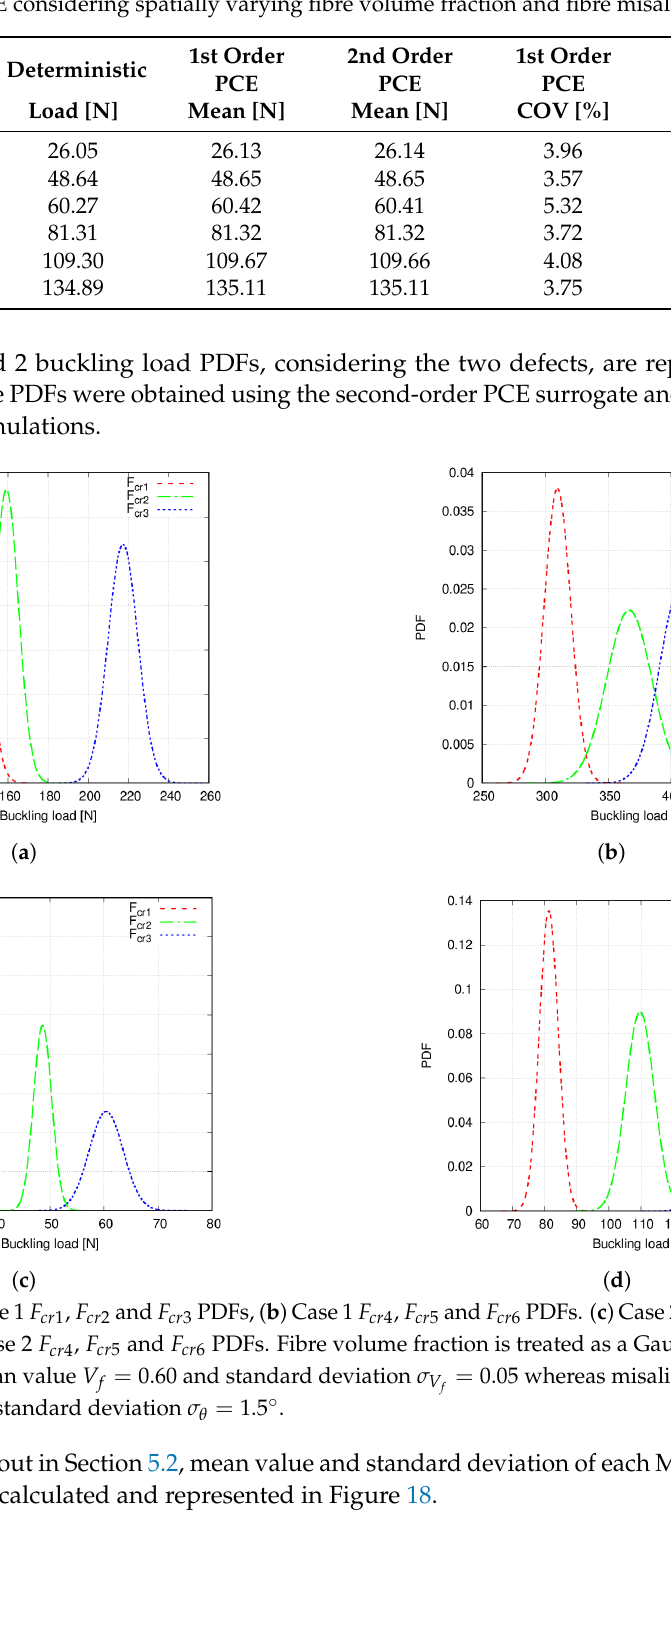
Table 11. Case 2 critical buckling loads mean value and COV calculated by means of first- and second-order PCE considering spatially varying fibre volume fraction and fibre misalignments.